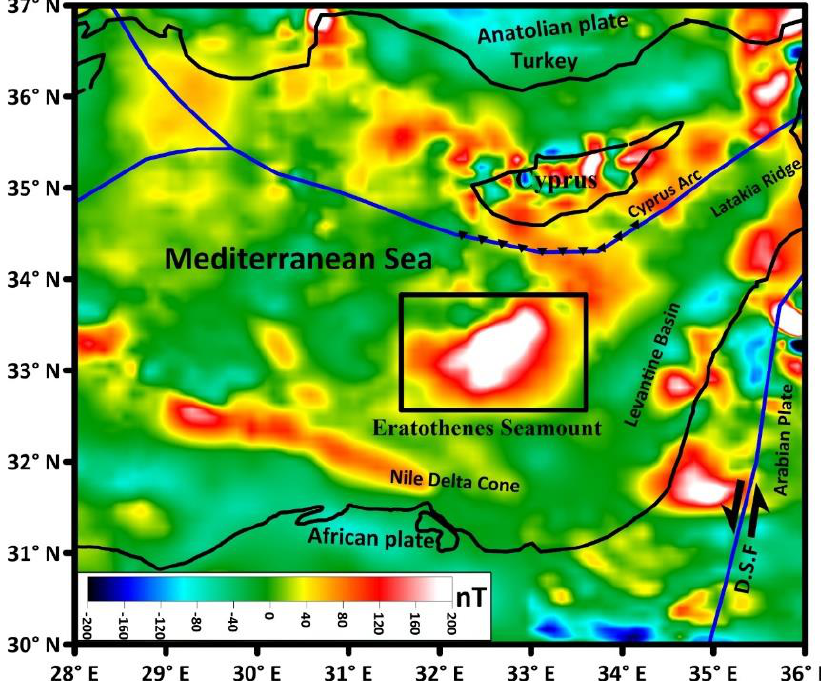
Figure 2. Magnetic anomaly (total field) map of the Eastern Mediterranean (compiled from Maus et al. [50]). The contour intervals are 40 nT.